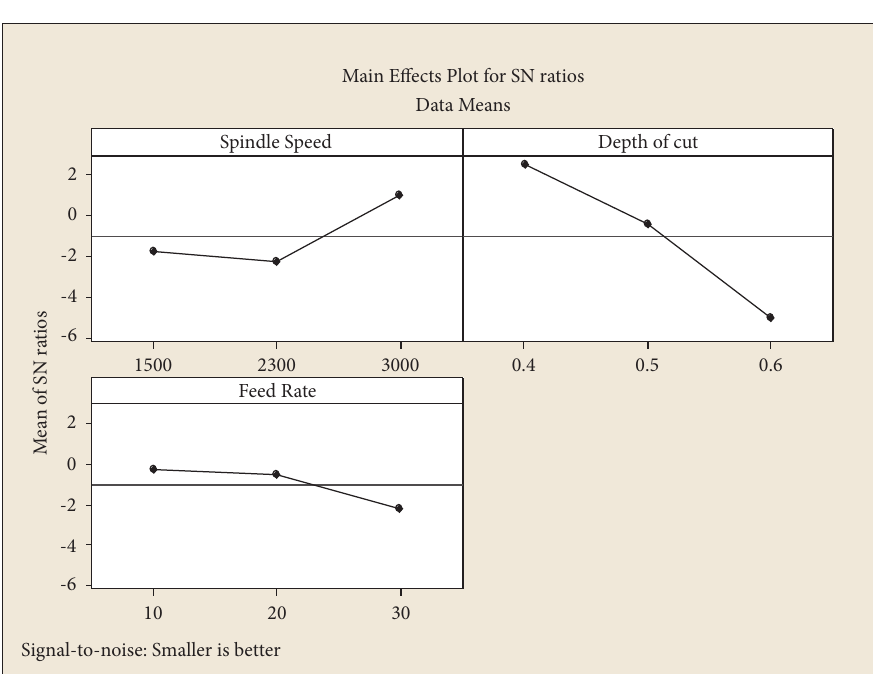
Figure 3: S/N ratio plot for R